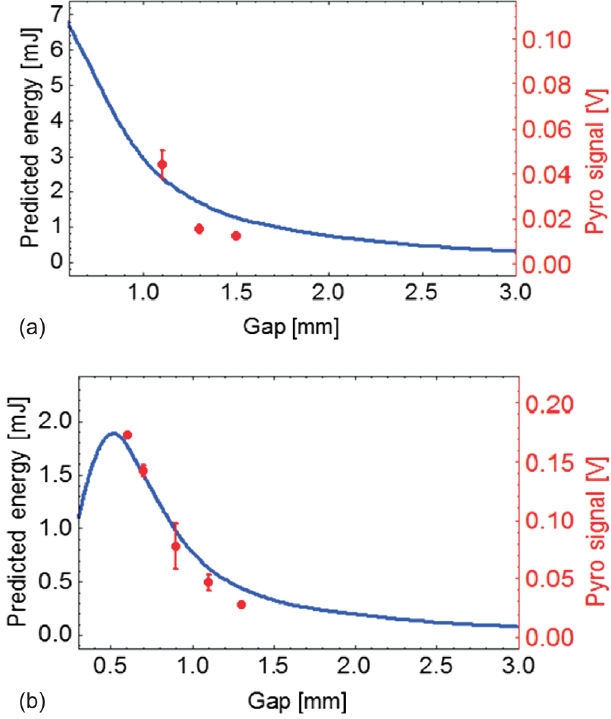
FIG. 16. Predicted (blue curve) and measured (red) peak pulse energy in a function of the gap, copper structure with a 3.2 nC electron beam (a) and copper-silver structure with a 1.6 nC electron beam